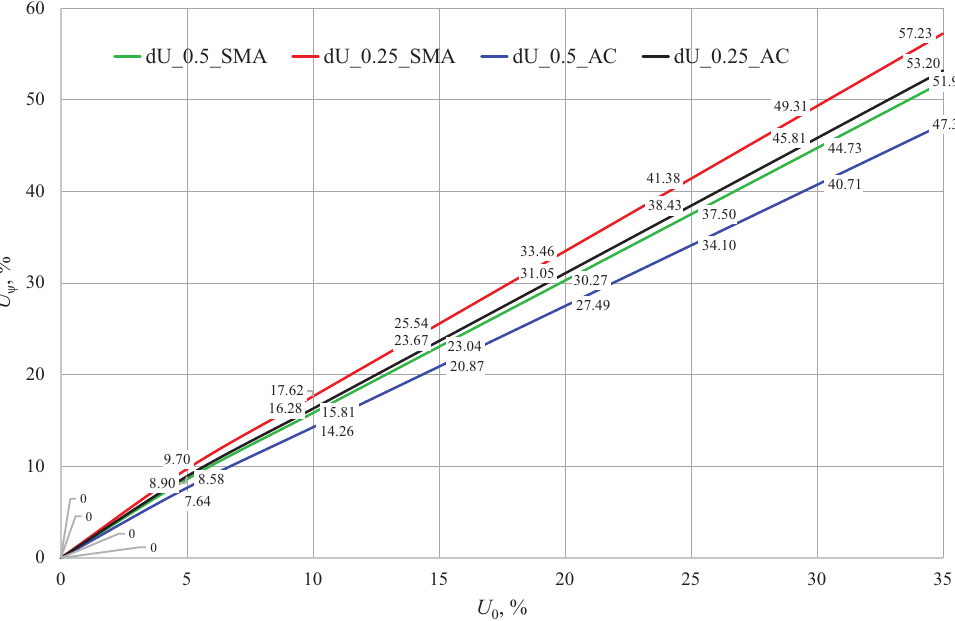
Figure 6. Change in indicator U (Eq. (9)) for the damageability level of SMA and AC type asphalt concrete of 0.25 and 0.5 depending on